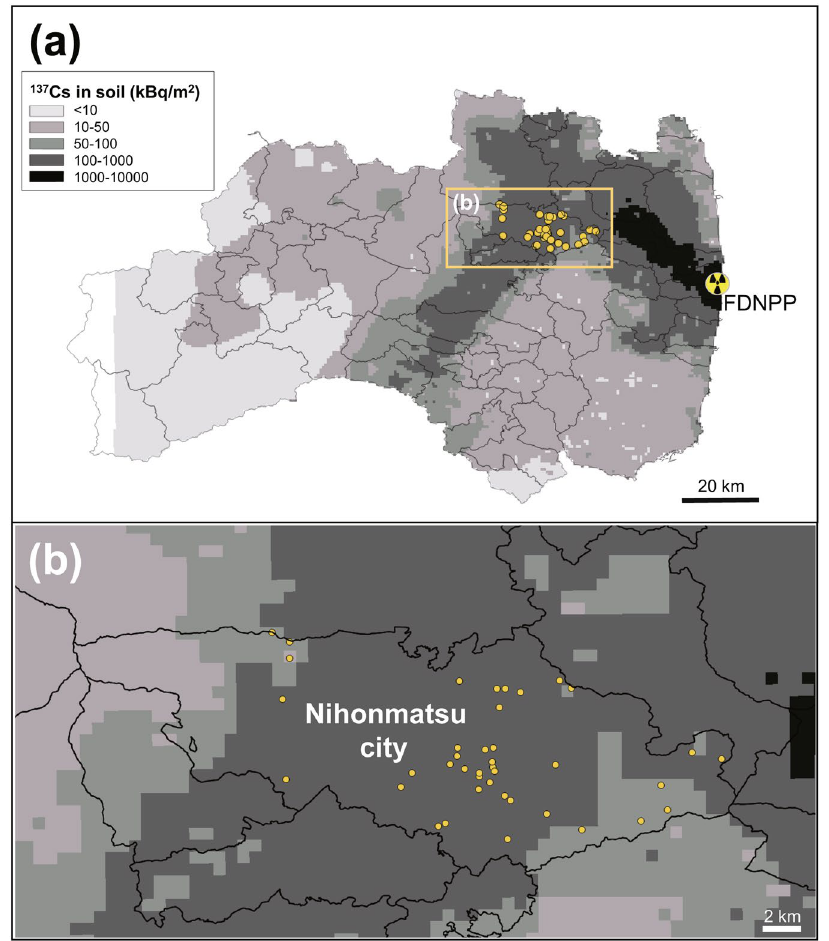
Figure 1. Study area and locations where the wild boars were captured. Orange dots indicate the points at which the wild boars were captured. Data on the amount of radiocaesium ( 137 Cs) deposits show the investigation results obtained by the Japan Atomic Energy Agency’s (JAEA) 5th airborne monitoring survey (https://emdb.jaea.go.jp/emdb/en/portals/b1020201/). ( a ) The entire area of Fukushima Prefecture and ( b ) Nihonmatsu city. This figure was created using QGIS 2.1.8 (https://www.qgis.org/en/site/). The map of Fukushima prefecture was obtained by Ministry of Land, Infrastructure, Transport and Tourism (MLIT)